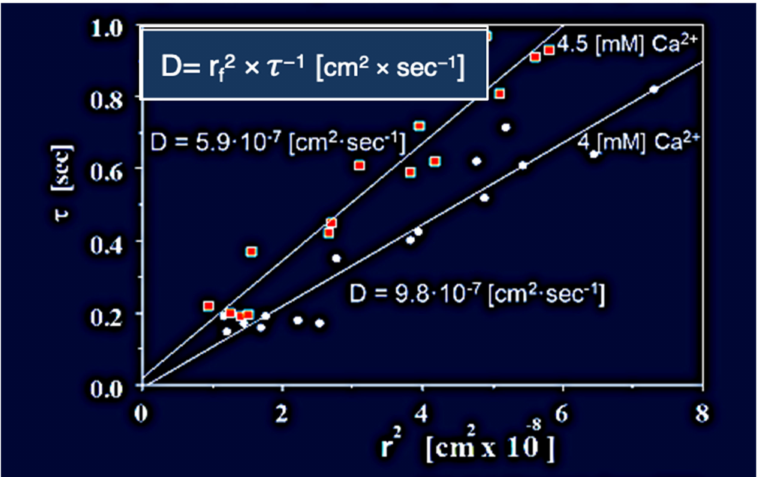
Figure 7. In here, Phaeocystis was equilibrated in ASW containing 4 mM and 4.5 mM [Ca 2+] at pH 8.2, 20 ◦ C, and stimulated to secrete by exposure to blue (450–490 nm) light. The swelling of exocytosed granules was monitored by video microscopy. In agreement with theory [25], the relationship between characteristic time ( τ ) of the swelling kinetics, and the second power of final radius (r f ) 2 of the exocytosed granules exhibit a characteristic linear function with a dimension of cm 2 × s − 1 that represent the diffusivity D = (r f ) 2 × τ − 1 [cm 2 × s − 1 ] of the exocytosed gel. Counterion concentration affects the diffusivity of exocytosed gels. In here Phaeocystis slight changes of concentrations of ASW [Ca 2+ ] from 4 mM to 4.5 mM at pH 8.2, 20 ◦ C, result in a corresponding decrease of D, from